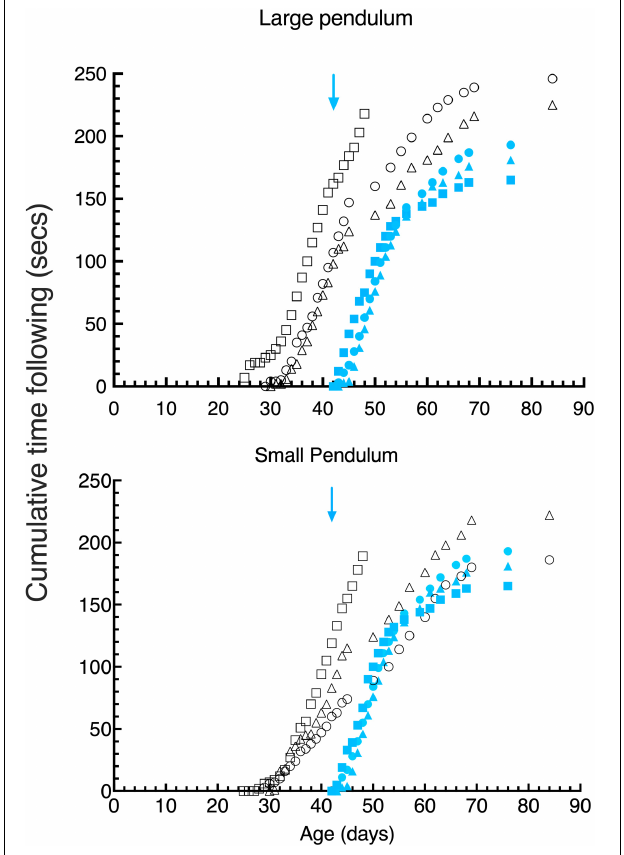
FIGURE 5 | Cumulative gaze- following behavior in daily 15 s episodes as a function of age for large (top) and small (bottom) pendulum swinging pendulums. Data are displayed for 3 light- exposed (open black symbols: C117 triangles, C118 circles, C119 squares) and 3 dark-reared (blue filled symbols: C114 triangles, C115 circles, C116 squares) kittens. The blue arrows indicate the age of the dark-reared kittens when they were first exposed to